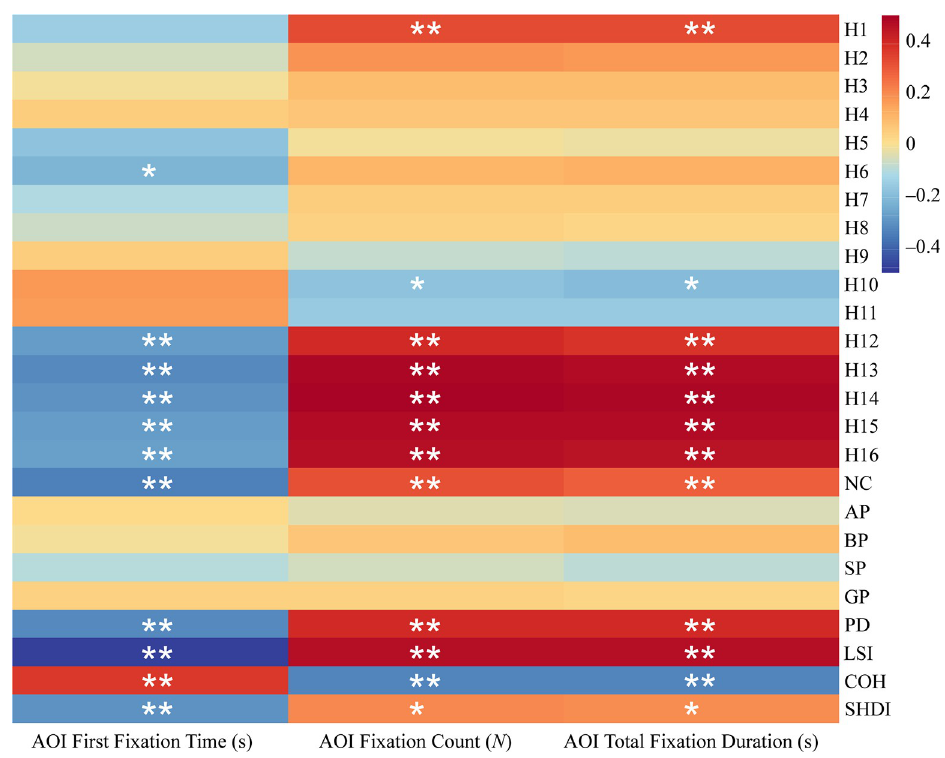
Fig 5. Correlation between color characteristics and visual behavior of forest color photos in all seasons. �� denotes p < 0.01, � denotes p <